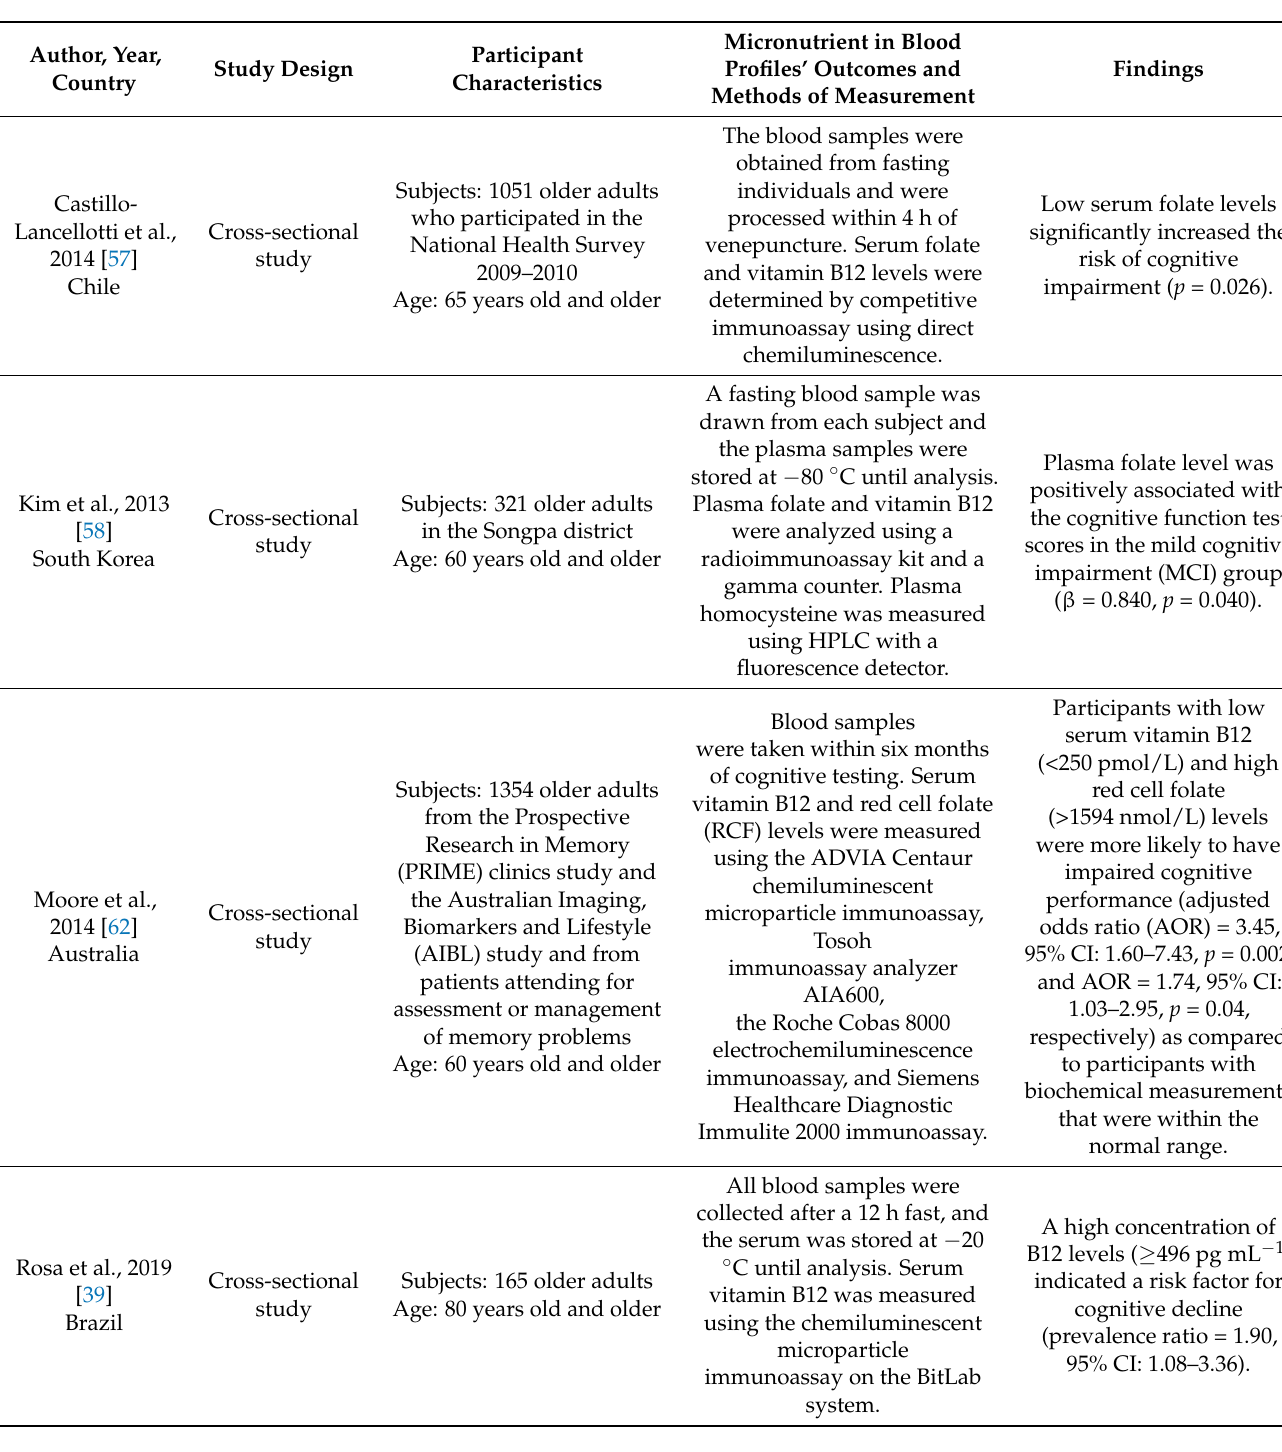
Table 4. Summary of studies evaluating the association between B vitamins with mild cognitive impairment, frailty, and cognitive frailty involved in the